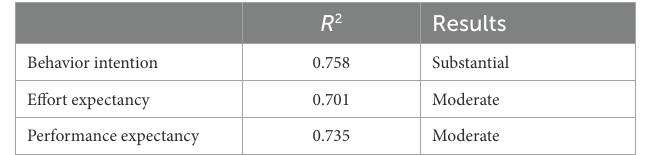
TABLE 8 Bootstrapping results on the effect. TABLE 9 R -squared